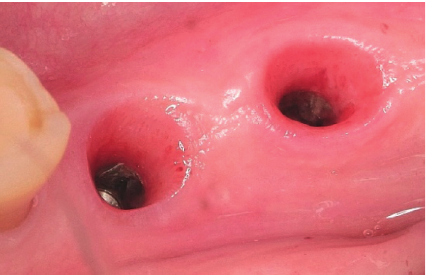
Figure 12: Emergence profile after gingiva former, 8 weeks after implant